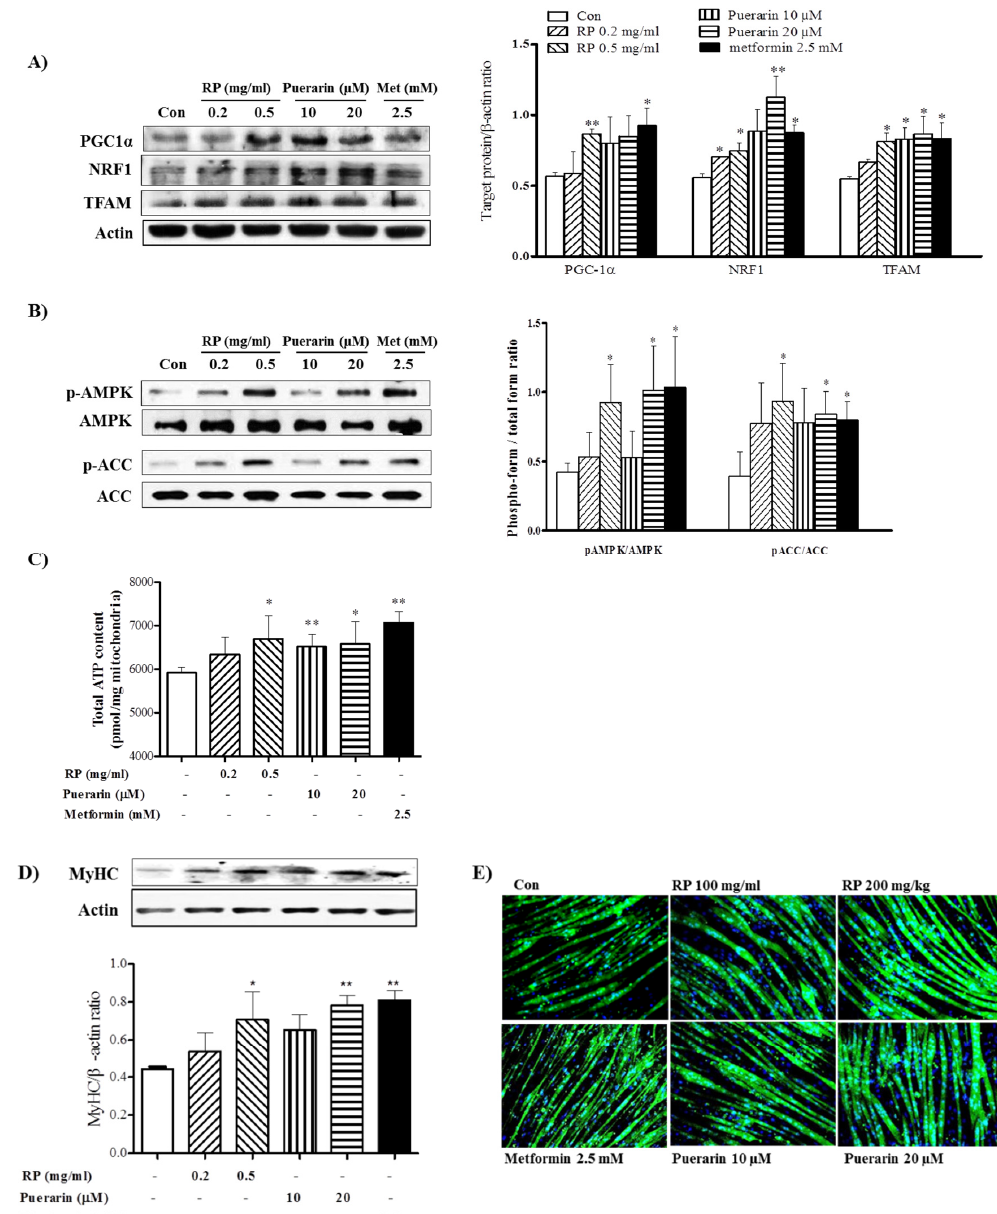
Figure 6. Effects of RP extract and puerarin on mitochondrial biogenesis and myotube hypertrophy in C2C12 myotubes. C2C12 myotubes were treated without or with without RP 0.2 mg/mL, RP 0.5 mg/mL, 10 µ M puerarin, 20 µ M puerarin, or 2.5 mM metformin. ( A ) PGC-1 α , NRF1, TFAM, acitin; ( B ) AMPK and ACC protein levels; ( C ) total ATP; ( D ) Myosin heavy chain (MyHC) protein levels and ( E ) Myotube morphology with immunofluorescence analysis. Results are presented as means ± standard errors of the mean (SEM) of three independent experiments. ** p < 0.01 and * p < 0.05 vs. non-treated controls. RP, Radix Pueraria lobata ; PGC-1 α , peroxisome proliferator-activated receptor gamma coactivator-1 alpha; NRF-1, nuclear respiratory factor-1; TFAM, mitochondrial transcription factor; AMPK, adenosine monophosphate-activated protein kinase; ACC, acetyl-CoA carboxylase; ATP, adenosine